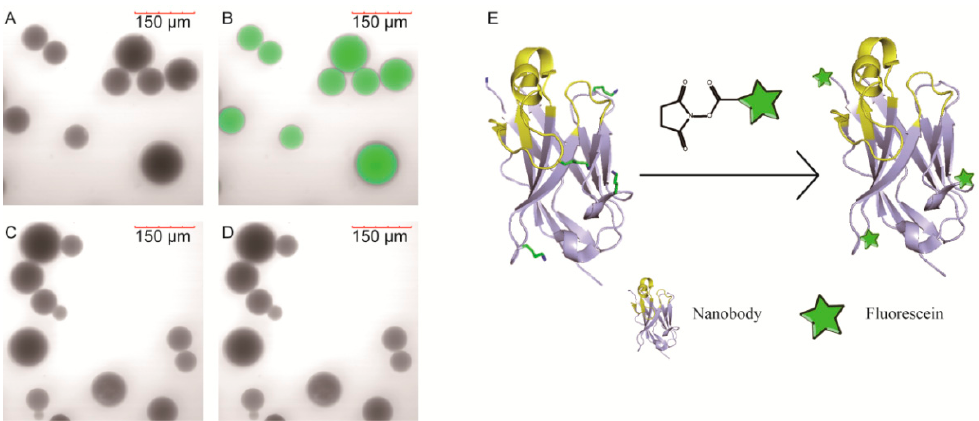
Figure 6. Labeled NB-1 stained beads visualized by laser scanning confocal microscope. ( A , B ) were